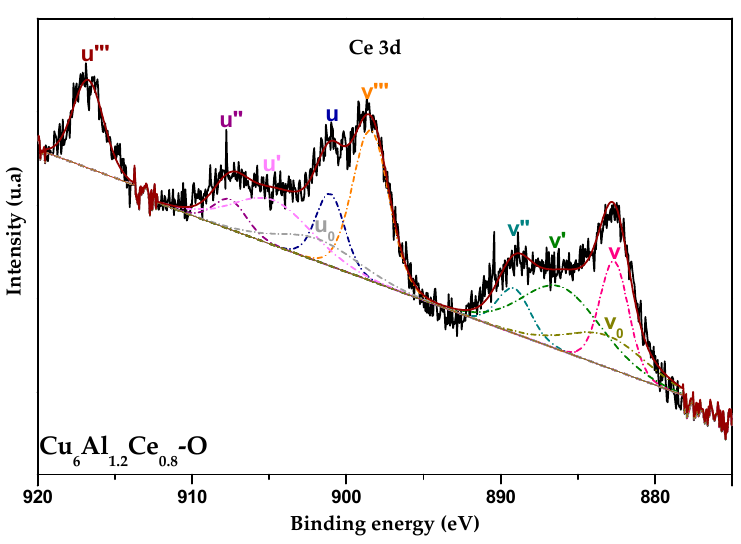
Figure 6. Fitted curve of Ce 3d spectrum for Cu 6 Al 1.2 Ce 0.8 -O sample. Catalysts 2020 , 10 , x FOR PEER REVIEW